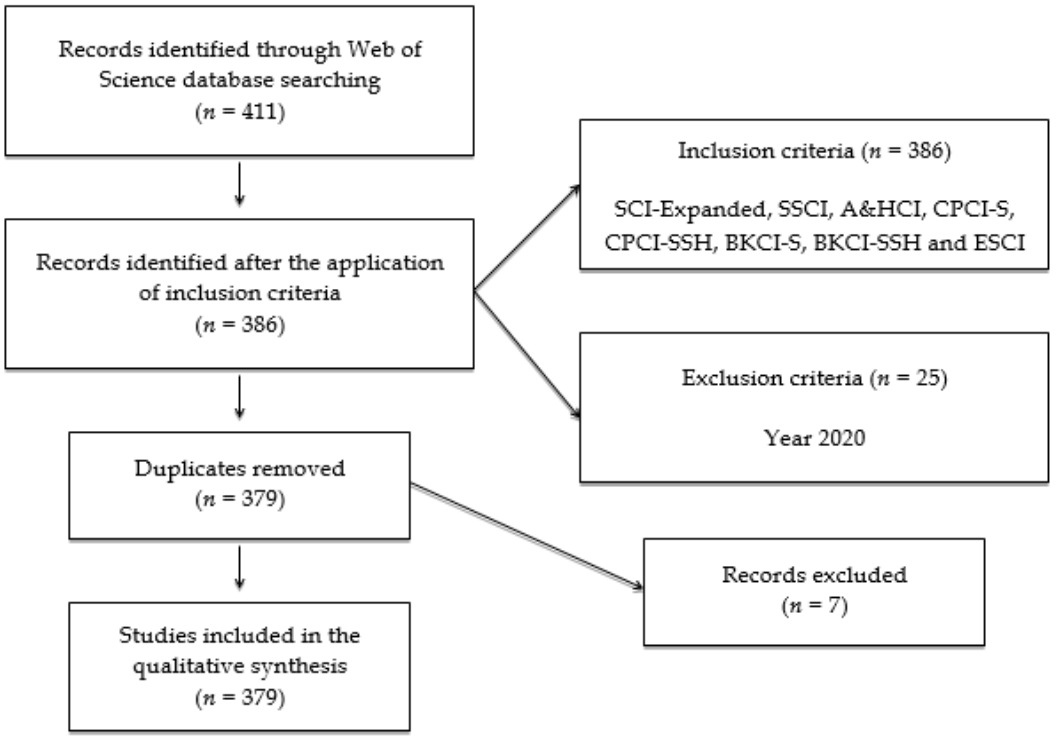
Figure 1. Flowchart according to the PRISMA Declaration .